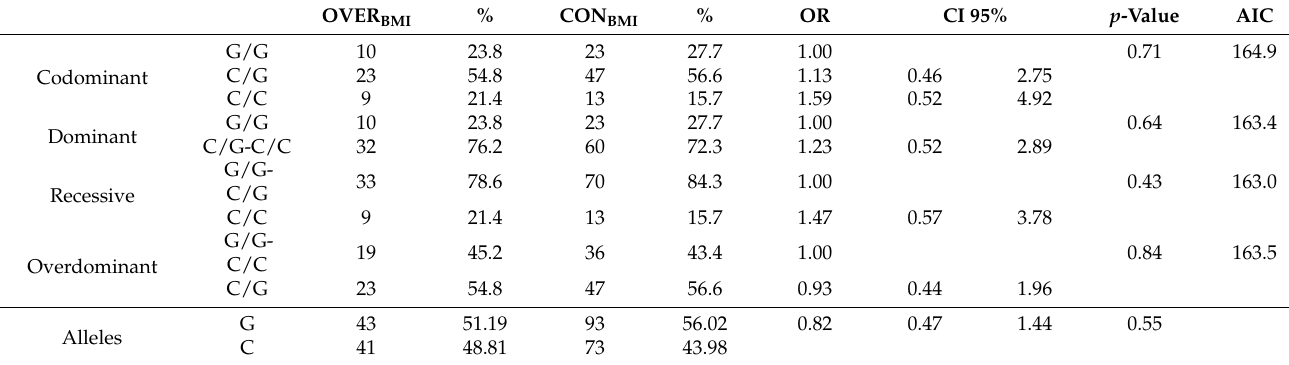
Table 3. Association analysis of the IL-6 rs1800795 polymorphism with BMI. OVER BMI